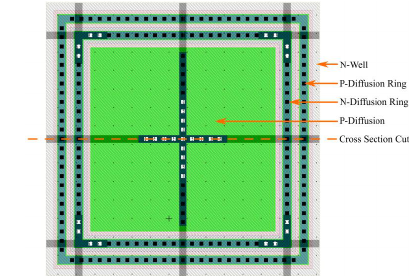
Figure 9. Diode layout.